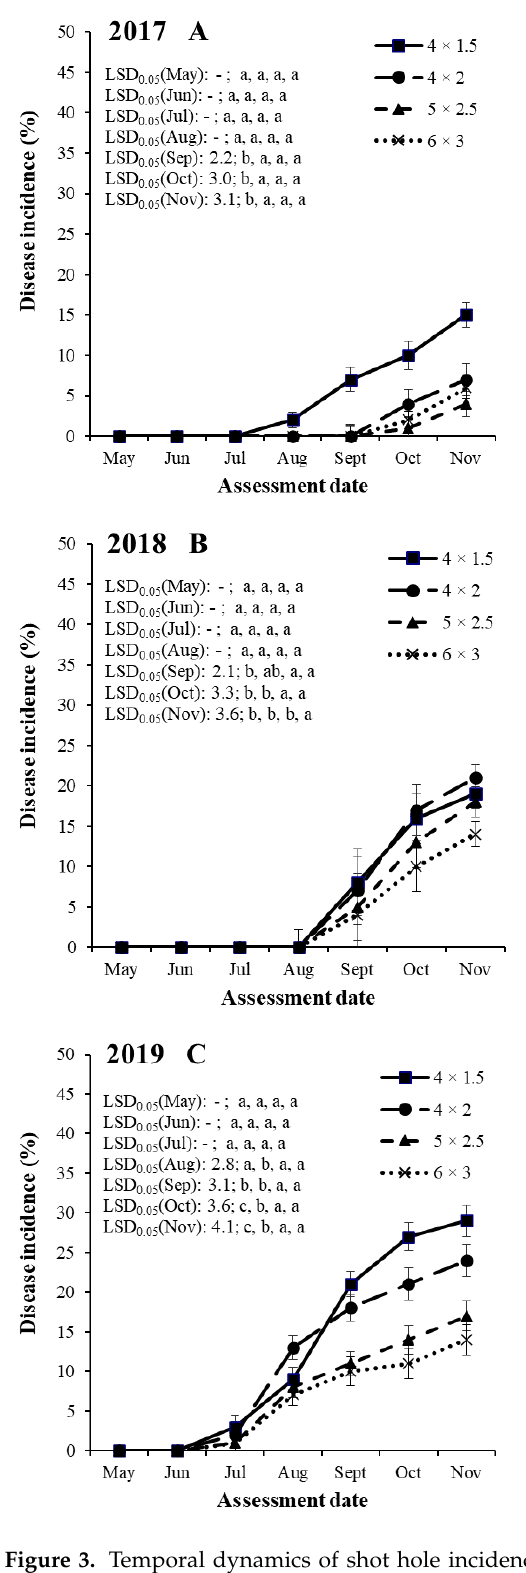
Figure 3. Temporal dynamics of shot hole incidence on plum cultivar ‘Stanley’ in four training systems (4 × 1.5, 4 × 2, 5 × 2.5 and 6 × 3 m) in the years of 2017 ( A ), 2018 ( B ) and 2019 ( C ) at seven assessment dates (May, Jun, Jul, Aug, Sept, Oct and Nov) in an integrated plum orchard at Debrecen-Pallag, Eastern Hungary. Details of explanations on significant symbols and LSD-test are given in Figure 1.